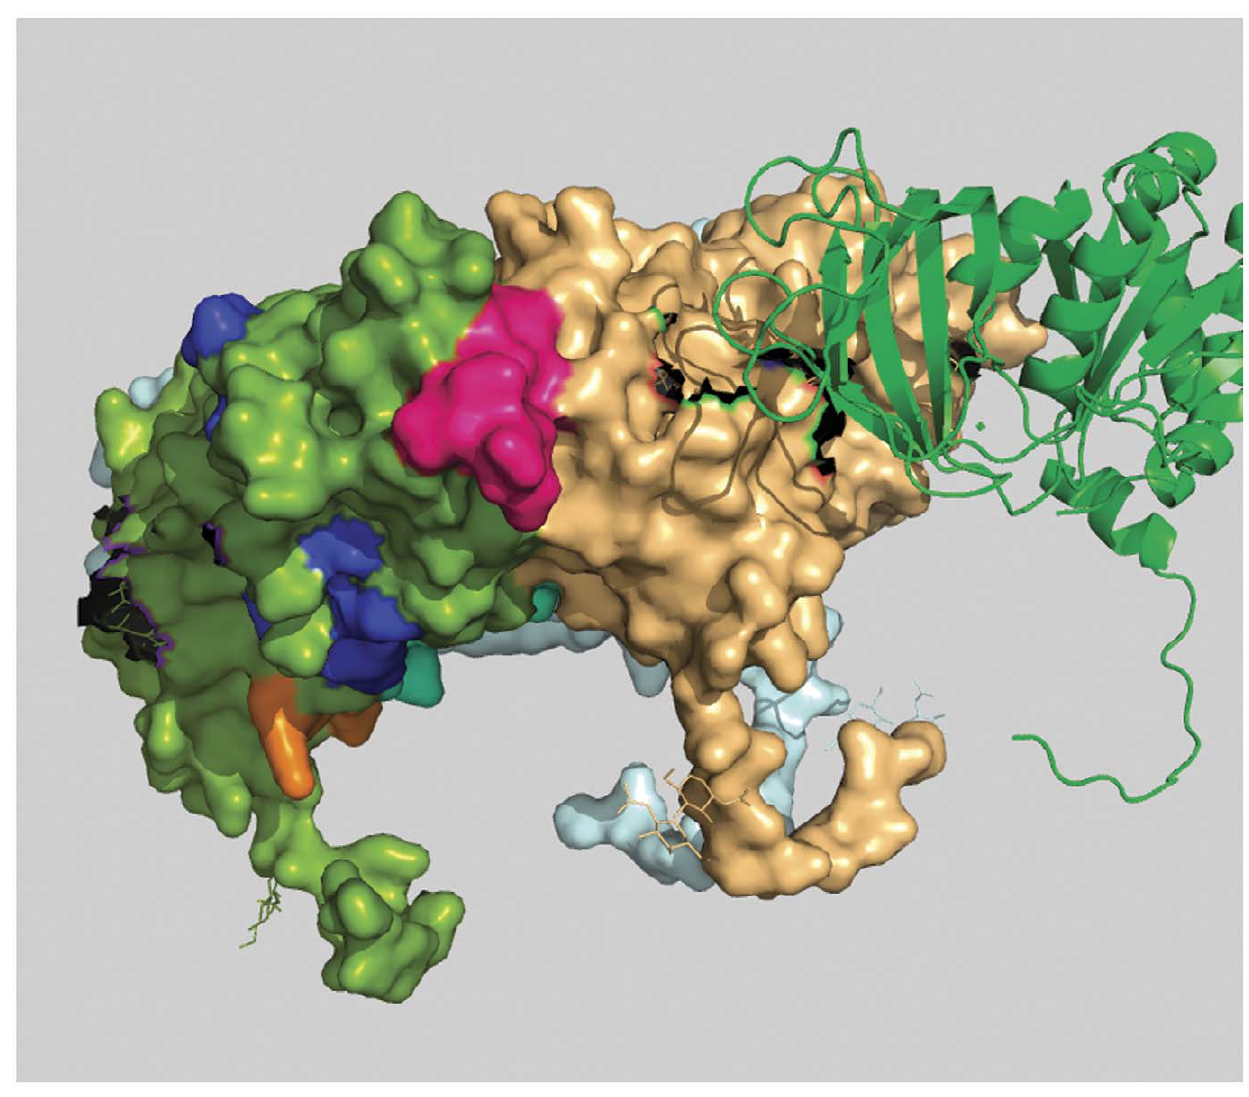
Figure 4. Position of peptide-a in a 3D space filling model of rotaviral trimeric VP7 protein. Peptide-a (194aa to 207aa) is shown in bright pink color and it is positioned in the green colored monomer.